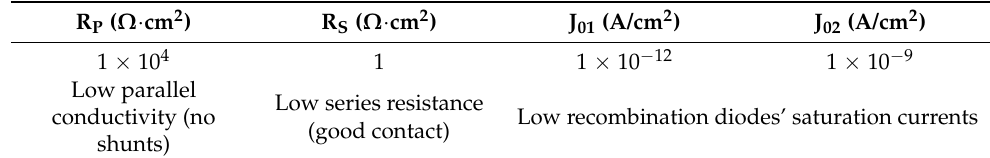
Table 2. Example values of the internal parameters of a good cell.